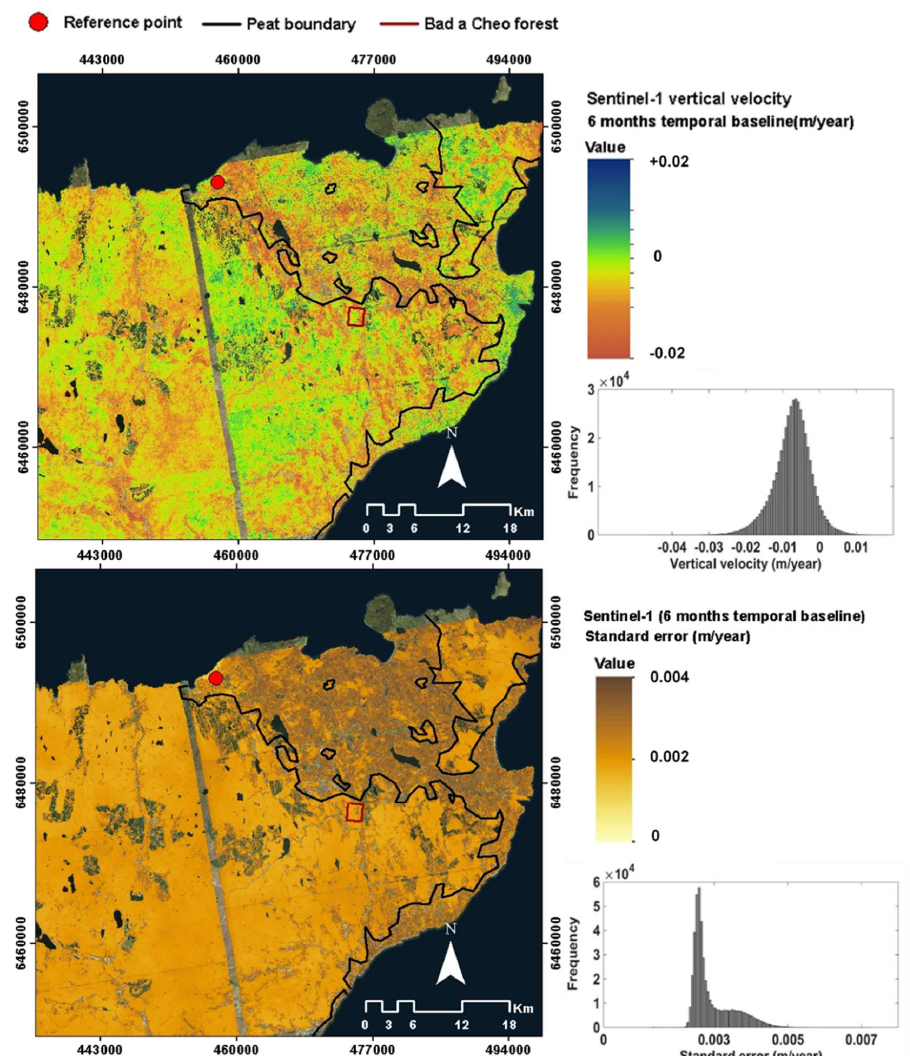
Figure 6. Sentinel-1 ISBAS (six-month temporal baseline) vertical velocity (m/year) map with standard error (m/year)mapand their statistical distribution. The red dot represents the location of the stable reference point (location—Dounreay on the Northern coast at 456984 E, 6493400 N) used in the ISBAS processing. The black line shows the boundary of peatland over Flow Country. The red rectangle represents the location of the Bad a Cheo forest Reserve. Projection: WGS_1984_UTM_Zone 30.